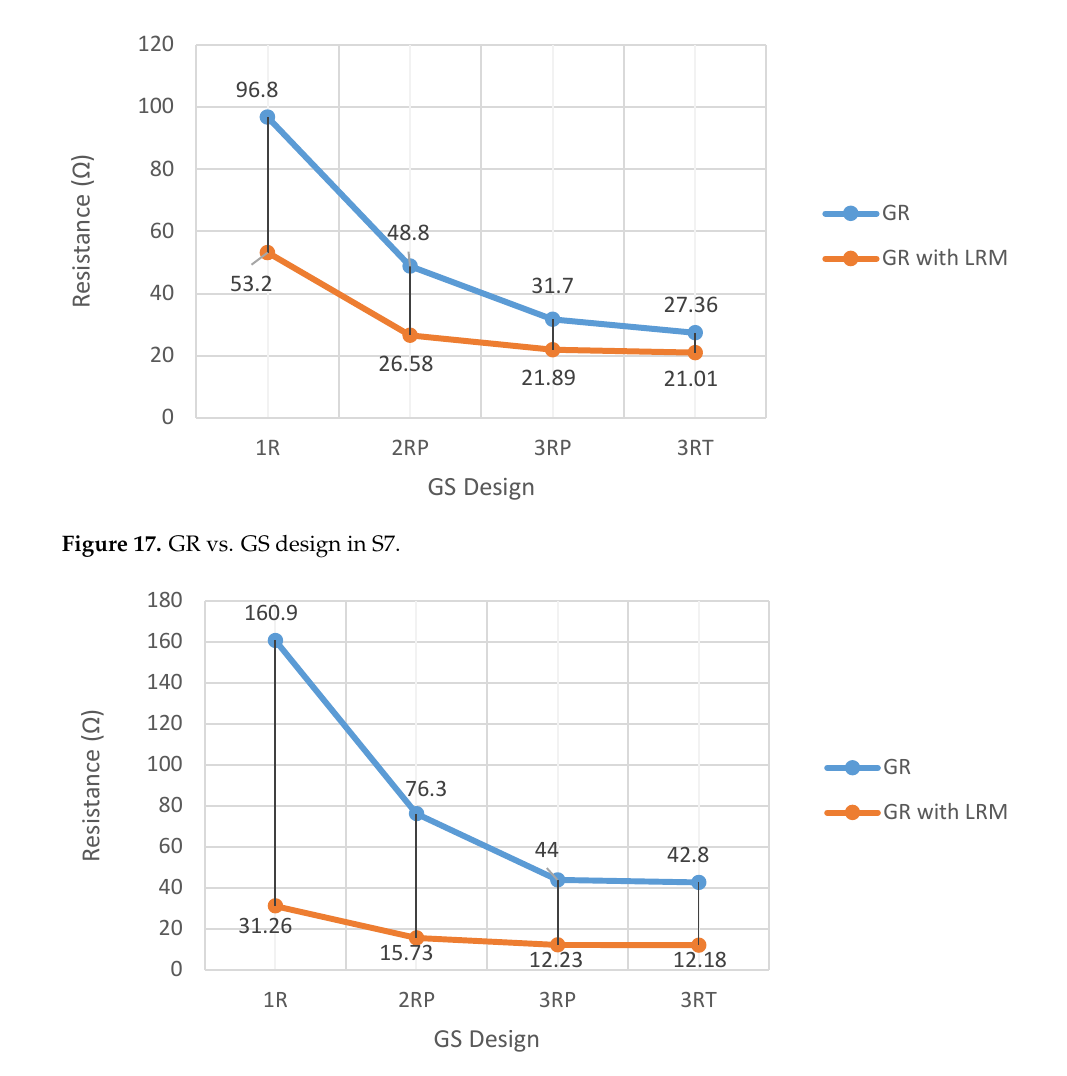
Figure 18. GR vs. GS design in